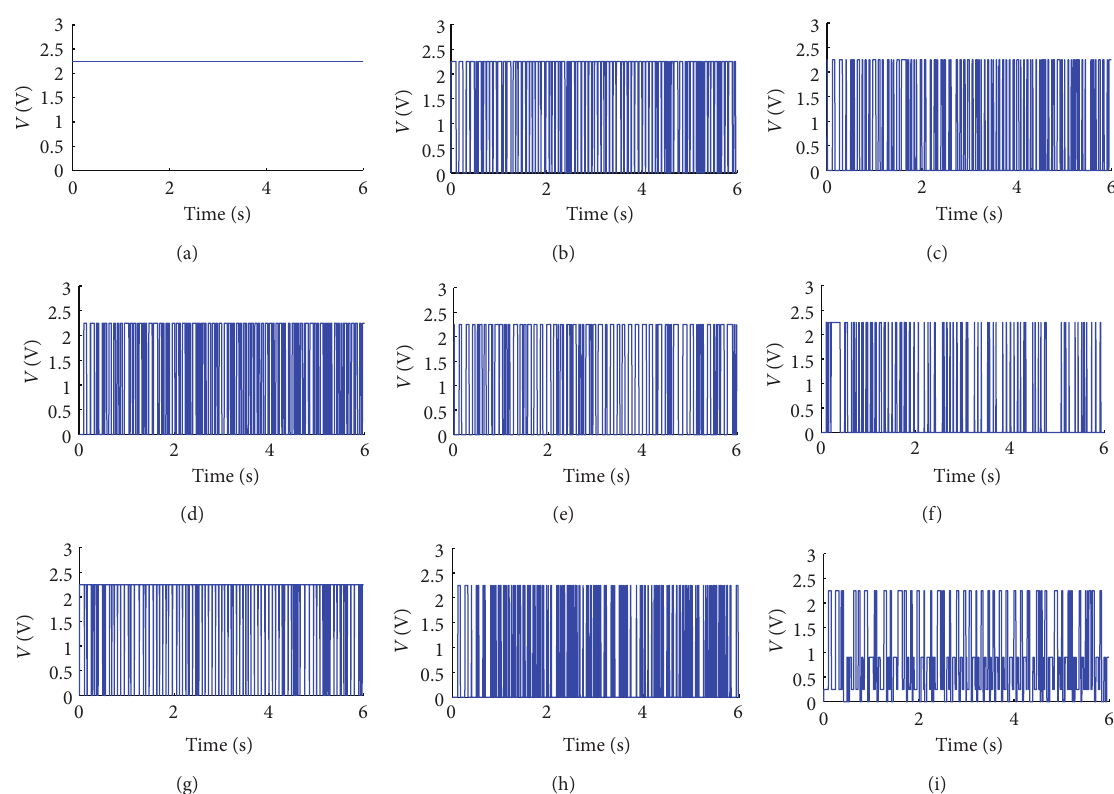
Figure 7: Input control voltage to the current driver of the MR damper: (a) passive on, (b) Lyapunov controller (A), (c) Lyapunov controller (B), (d) quasi-bang-bang controller, (e) decentralized bang-bang controller, (f) modulated homogenous friction controller, (g) maximum energy dissipation controller, (h) clipped-optimal controller, and (i) proposed